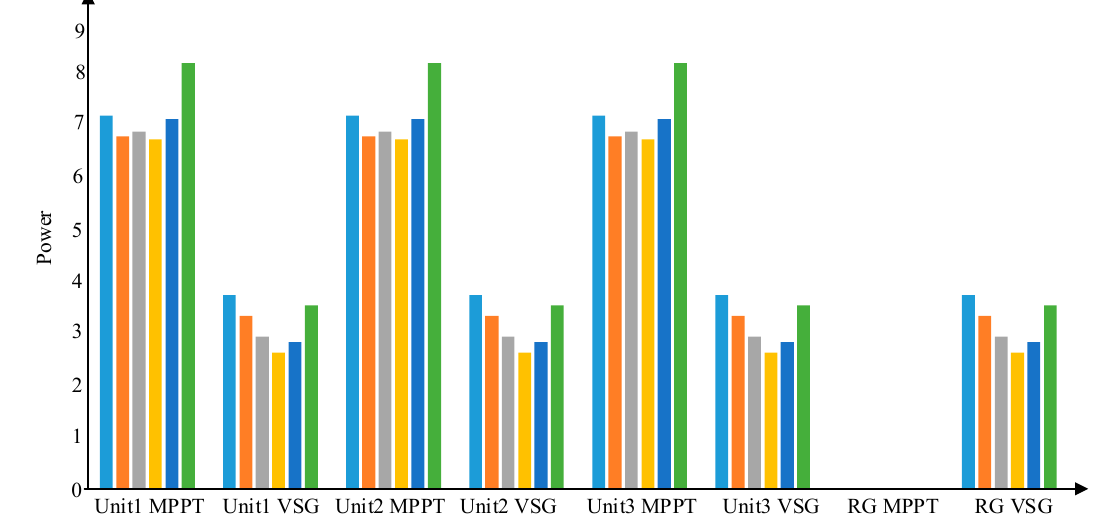
Figure 15. Downward reserve allocation for SGs and RG under MPPT or VSG mode.